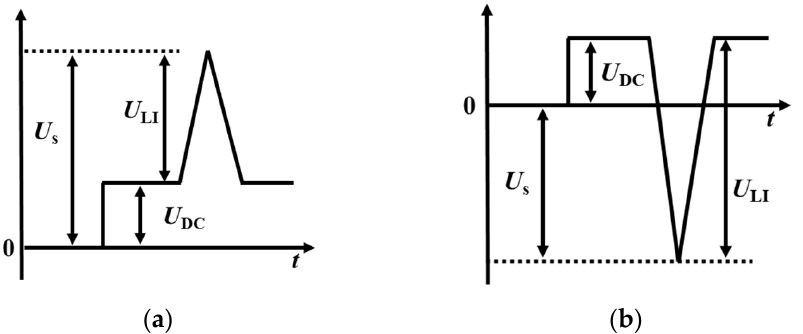
Figure 8. Superimposed DC and lightning impulse voltage waveforms. ( a ) Positive DC + Positive LI; ( b ) Positive DC + Negative LI.